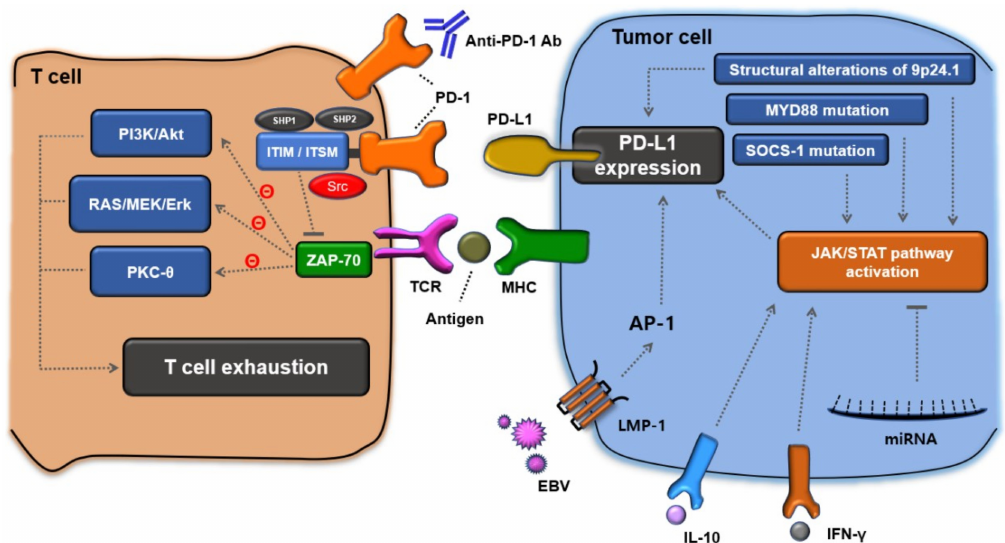
Figure 1. Immune evasion mechanisms associated with the PD-1/PD-L1 signaling pathway in the tumor microenvironment of lymphoma. Upon PD-1 engagement, SHP-1/2 is recruited and then the downstream signal of TCR is inhibited. Ultimately, T-cell exhaustion and tolerance is induced. Meanwhile, PD-L1 expression is promoted via multiple mechanisms, such as alterations of chromosome 9p24.1, MYD88 mutation, SOCS-1 mutation, EBV infection, and increased cytokines (IFN- γ , IL-10); hence cancer-cell proliferation and dissemination is